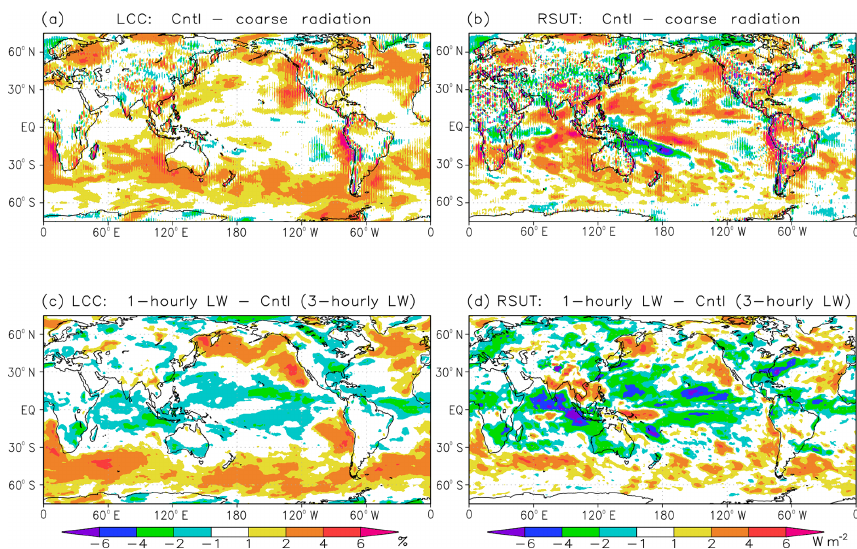
Figure 8. Impacts of (a, b) increased horizontal resolution for the radiation calculation and (c, d) increased frequency of calculation for longwave radiation on (a, c) low-cloud cover (%) and (b, d) TOA upward shortwave radiative flux (Wm − 2 ). Panels (a, b) show results for the control model (calculation for every single grid box) minus those for an experiment with calculation for every two latitudinal grid boxes. Panels (c, d) show results for an experiment with 1-hourly longwave radiation calculation minus those for the control model (3-hourly